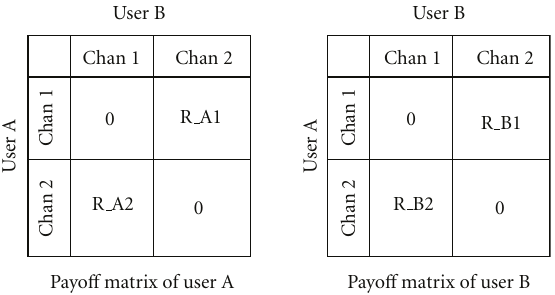
Figure 3: Examples of payo ff matrices in a two-player and two- channel game of aloha-like spectrum